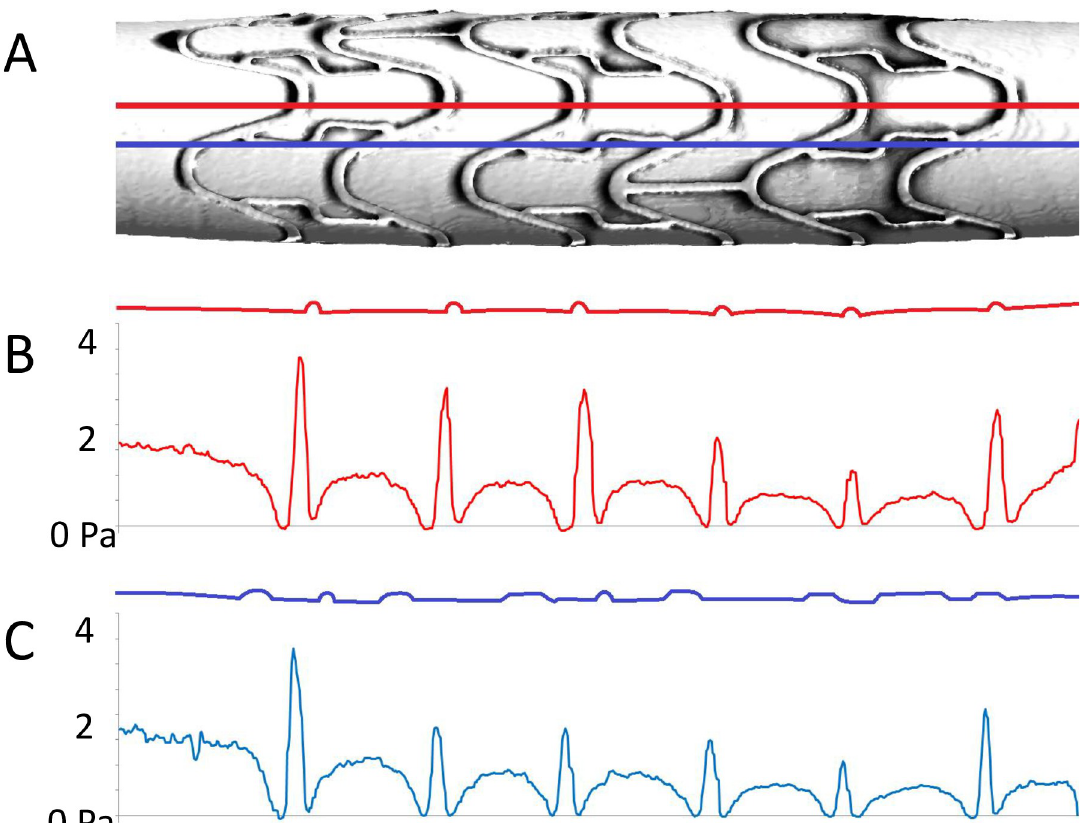
Fig 8. Wall shear stress along reference lines within a Matrix coronary stent. In silico models were reconstructed from coronary stent μ CT data and used for CFD analysis. Plotting data along reference lines in the direction of flow revealed elevated wall shear stress on stent struts, greatly reduced shear stress immediately up and downstream of struts, and recovery of shear stress in inter-strut regions. A: Matrix stent, with two reference lines (red and blue); B: Wall geometry (top) and shear stress along the upper, red reference line; C: Wall geometry (top) and shear stress along the lower, blue reference line. Flow from left to right, 1 Pa average wall shear